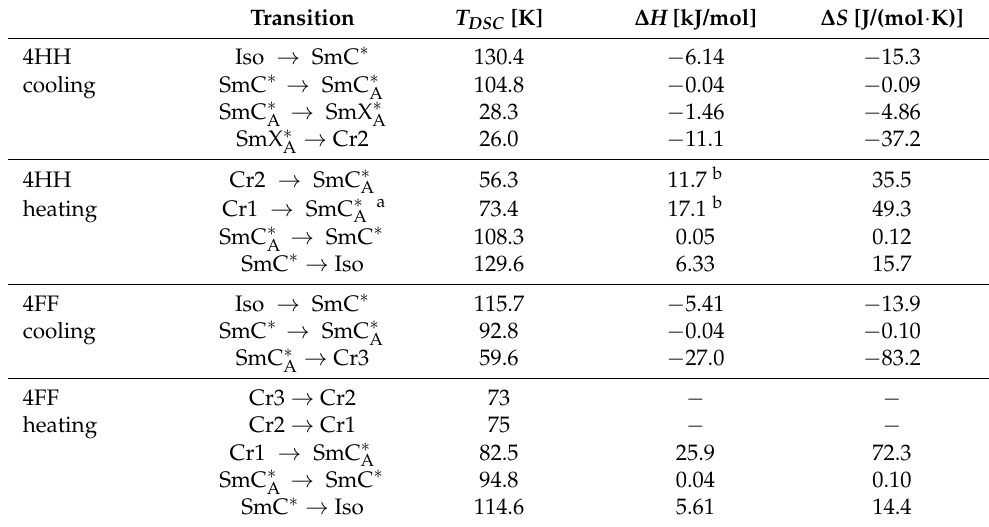
crystallization starts shortly after melting of Cr2; b values for 3 ◦ C/min rate.